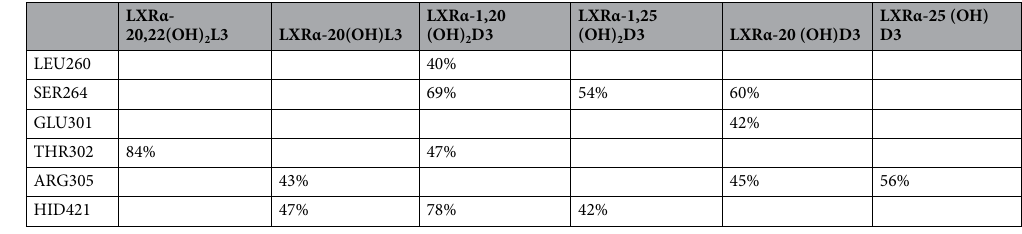
Table 5. Occupancy of hydrogen bond (no less than 40%) formed between LXRα and D3 or L3 derivatives.